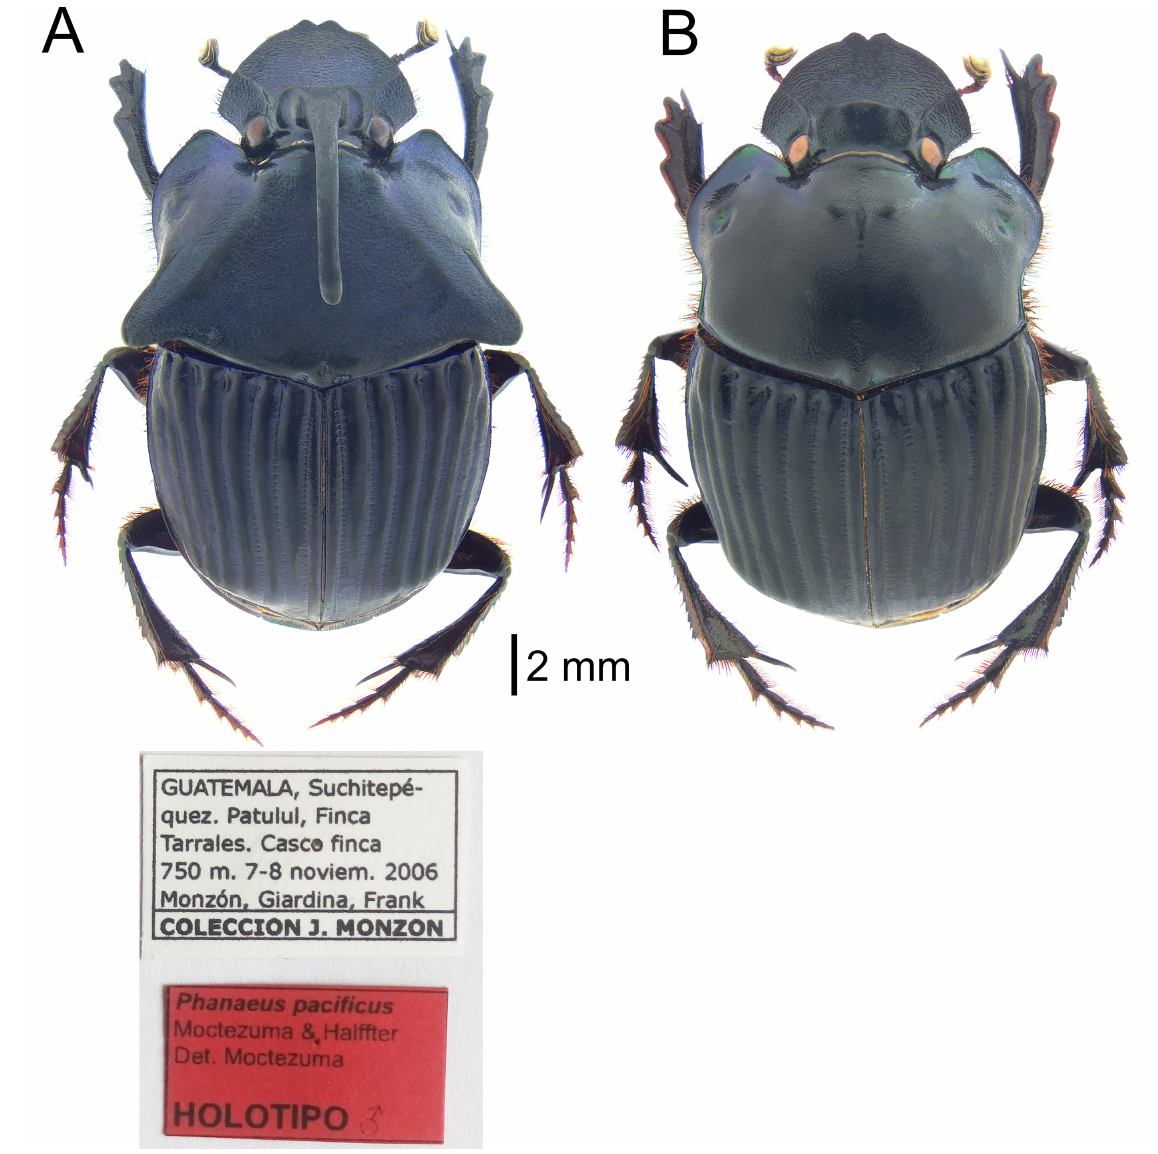
Fig. 9. Phanaeus pacificus sp. nov. A . Holotype, ♂ (UVGC). B .